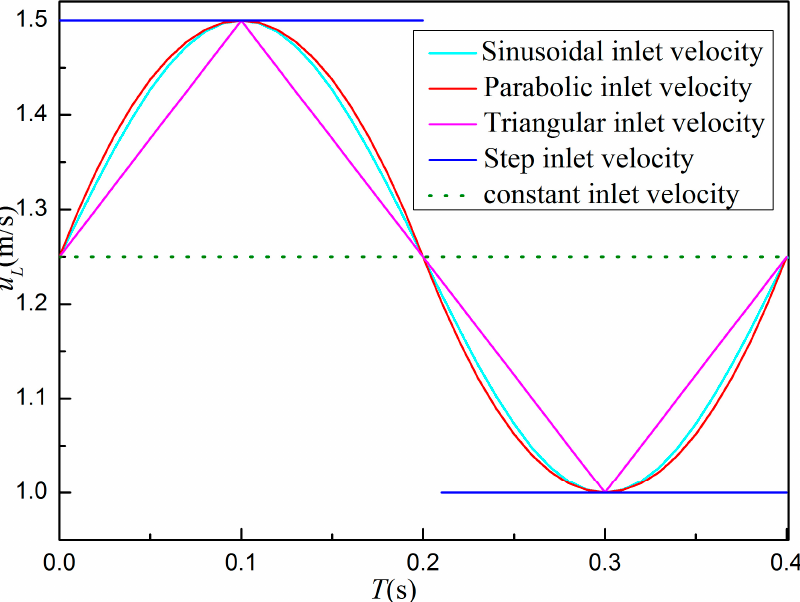
Figure 1. Different left inlet flow patterns with ∆ ϕ = T /2 used in this work.